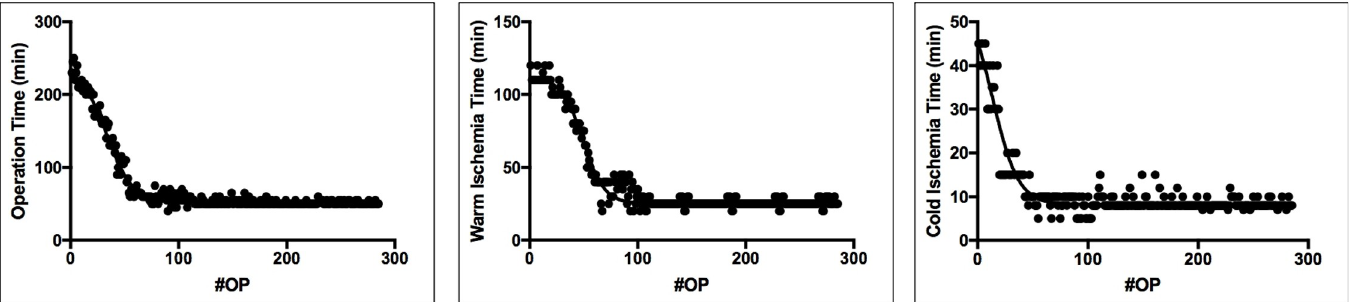
Fig 9. a-c: Graphical illustration of the learning curve: Operation times . Total operation time (a), warm ischemia time (b), and cold ischemia time (c) with time in minutes on the y-axis and number of operations on the x-axis (#OP).